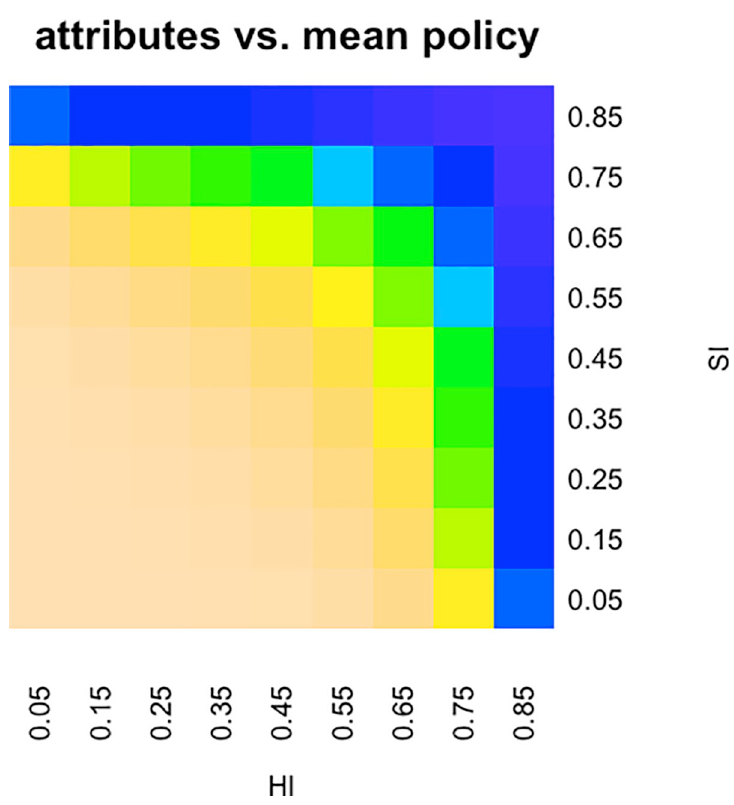
Fig 6. Mean partner policy depending on attributes. Okra: preference for returning a large amount to the participant. Blue / purple: preference for returning very little.